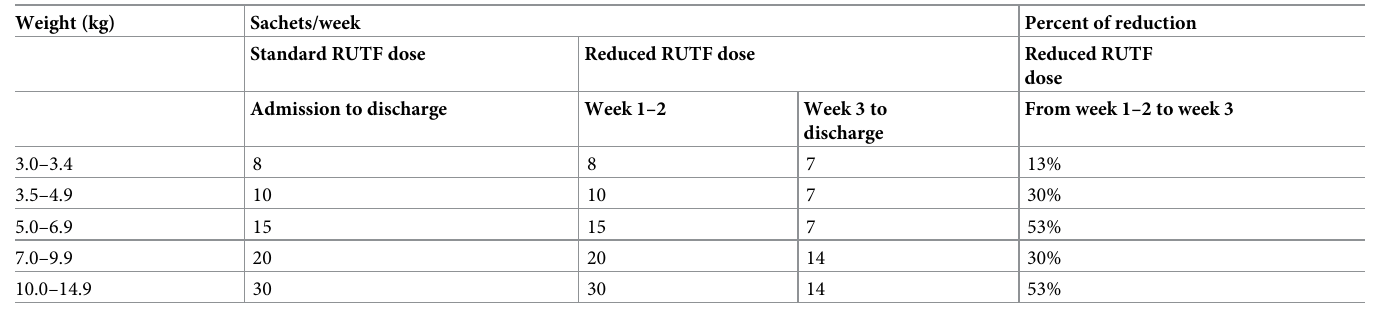
Table 1. RUTF dose in reduced and standard dose